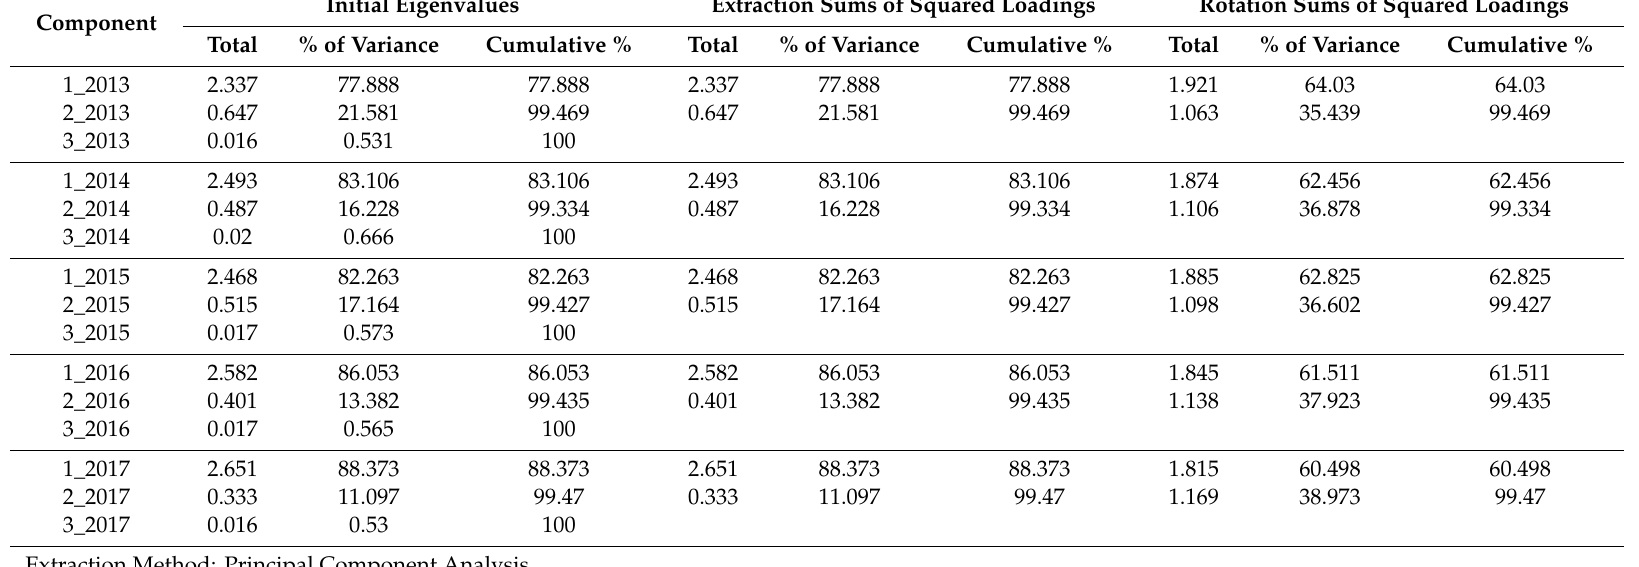
Table 4. Total variance explained.